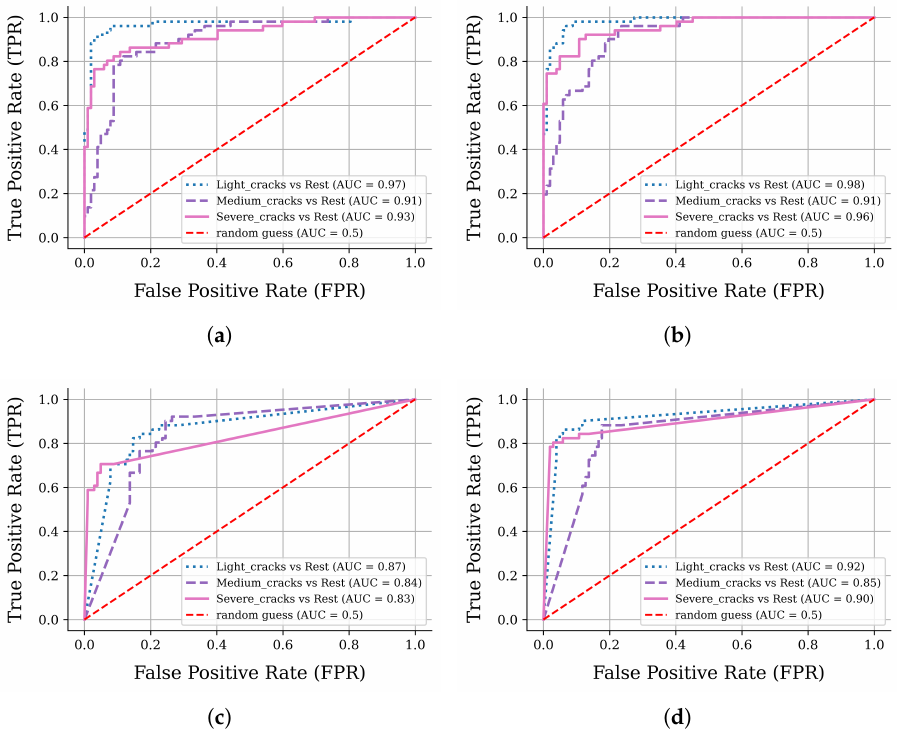
Figure 12. ROC for ( a ) VGG16-ANN, ( b ) ResNet50-ANN, ( c ) VGG16-kNN, ( d ) ResNet50-kNN model in the RGB dataset.